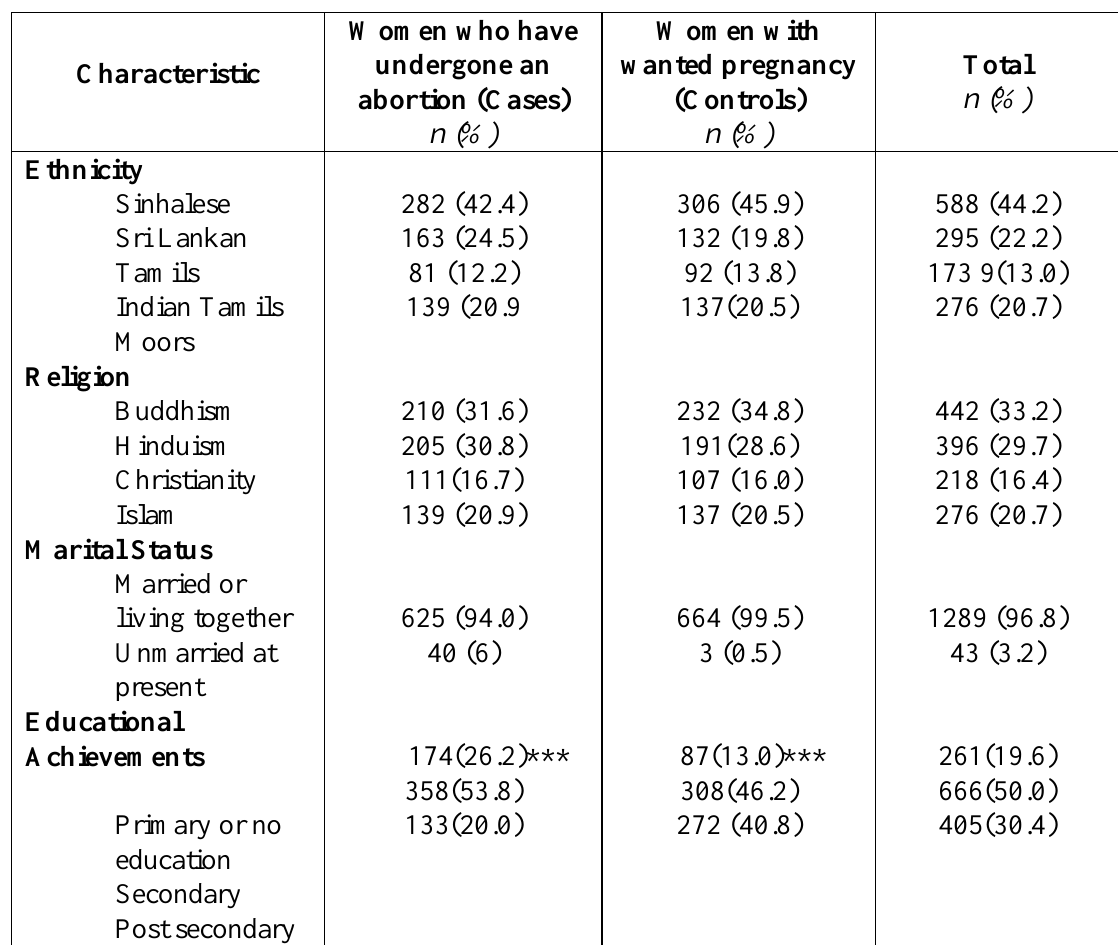
Distribution of respondents by socio demographic